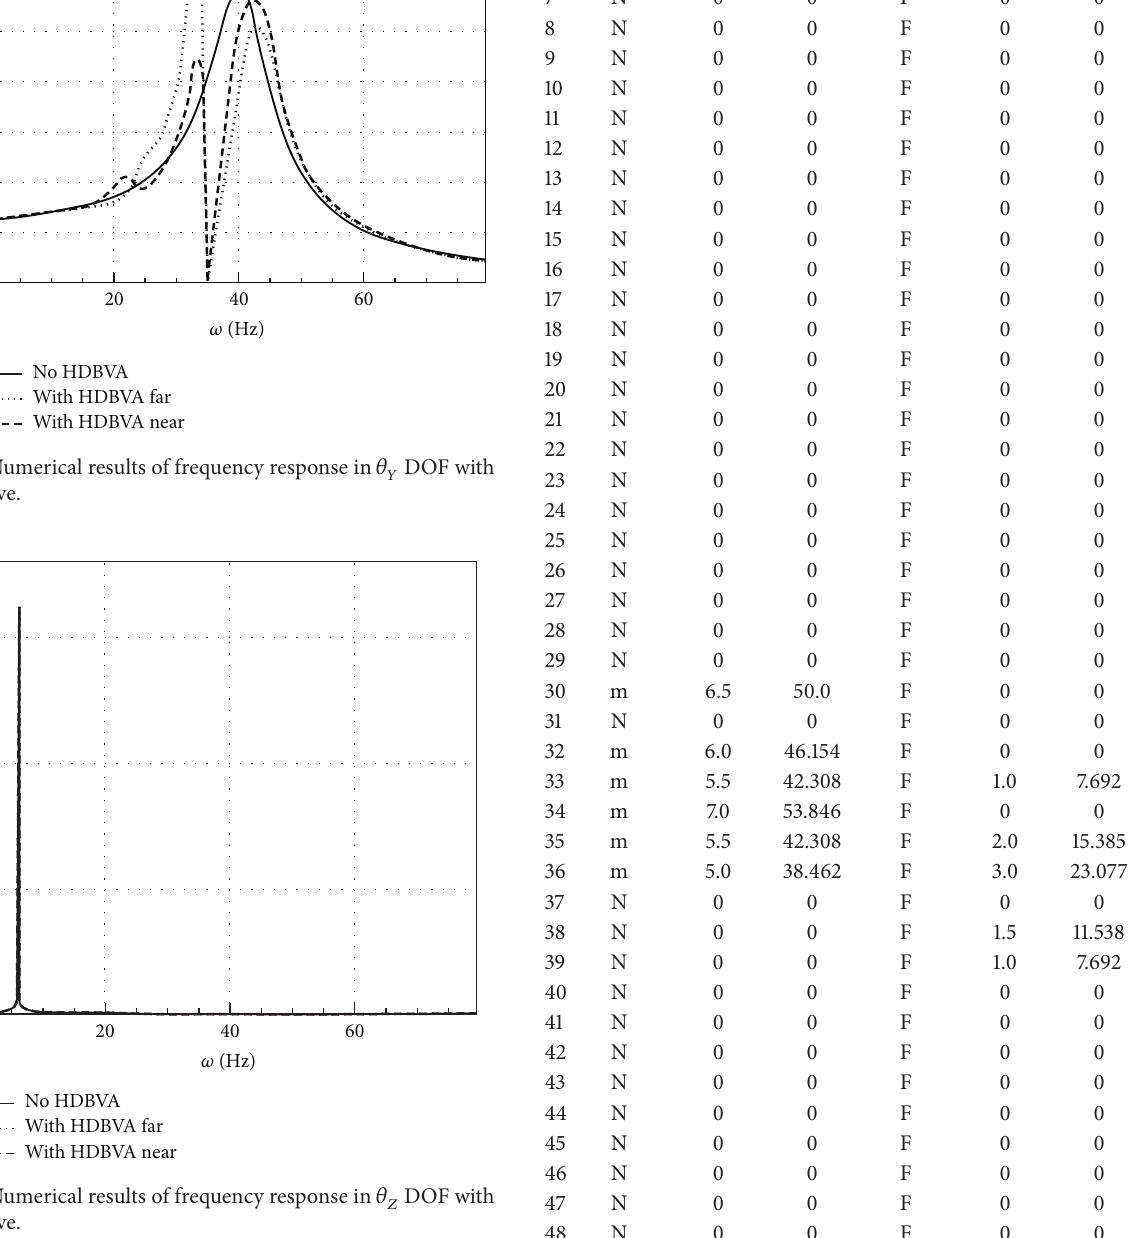
absorber locations after sliding. In these graphs, the vertical axis measures the distance percentage between the initial and final locations of the vibration absorber. HDBVA1